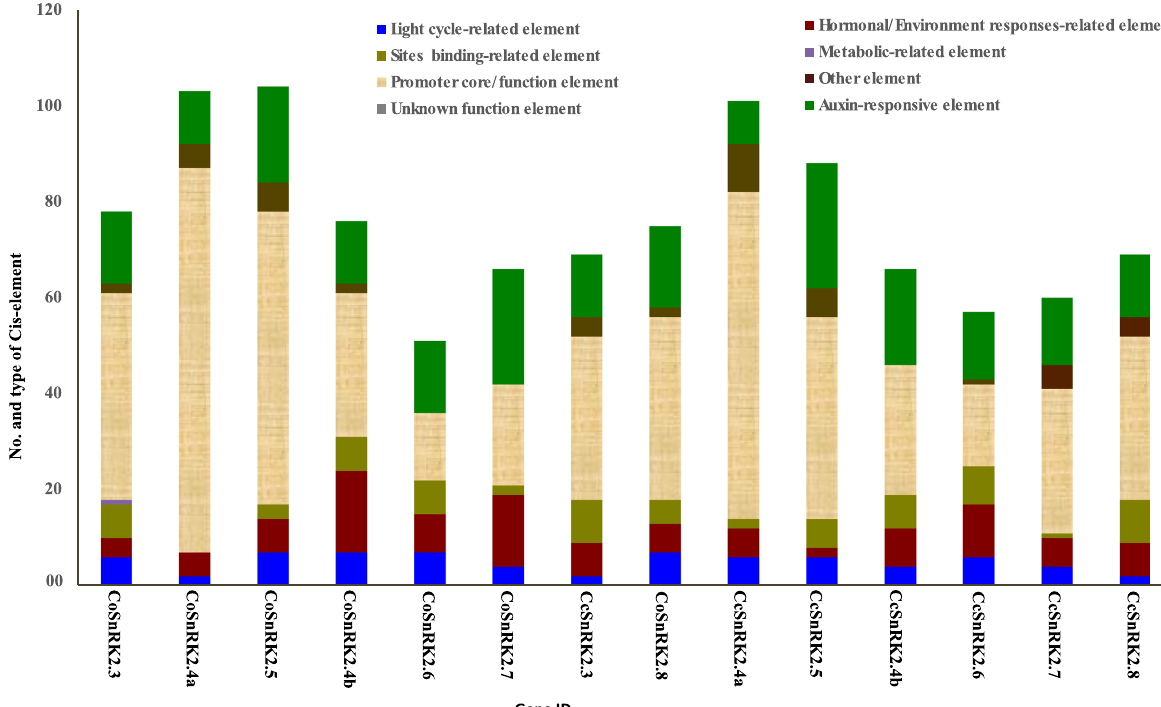
Fig. 6 Promoter analysis of CoSnRK2 and CcSnRK2 genes. The numbers of different cis-elements were presented in the form of bar graphs; Different cis-elements with the same or similar functions are shown in the same